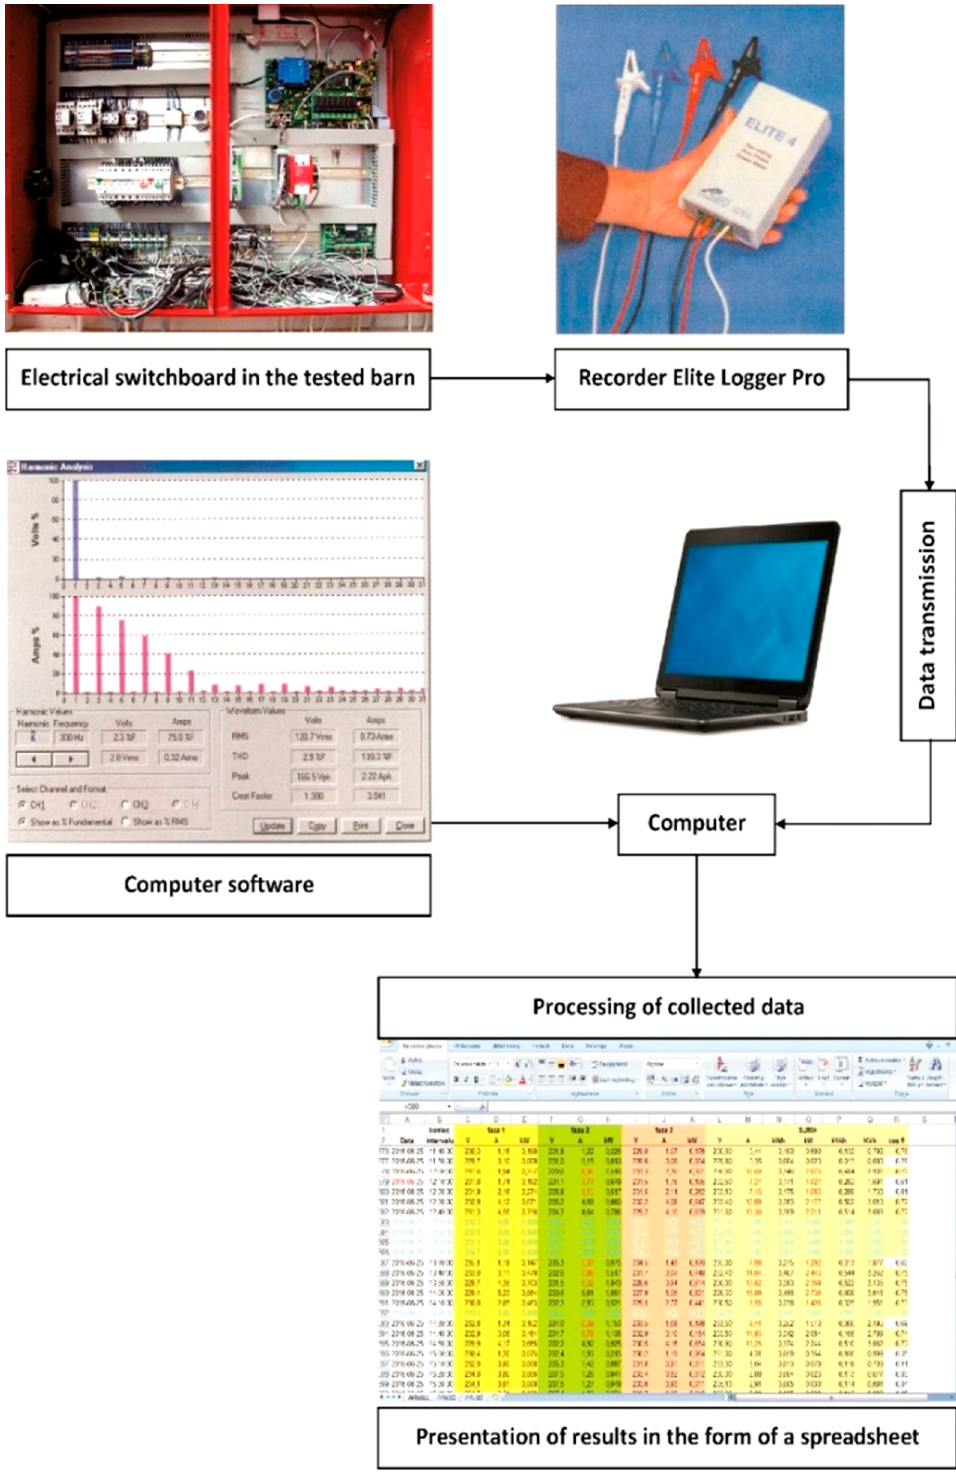
Figure 1. Diagram of the research stand for recording the electrical energy consumption during feed mixing and feeding in the